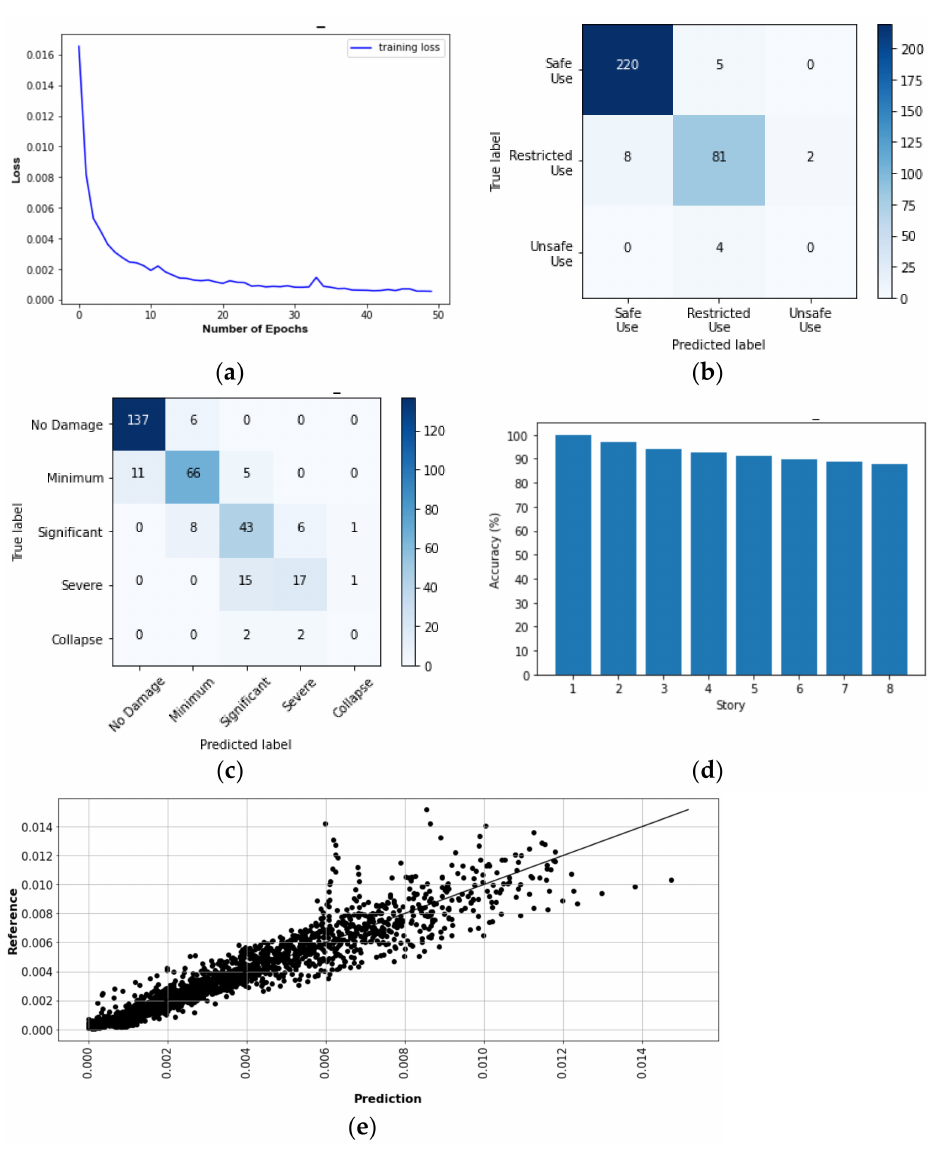
Figure 19. SD results of the TP and VP for Toyohashi Fire Station building: ( a ) convergence curve—loss in the TP; ( b ) confusion matrix—usability of the building by VP; ( c ) confusion matrix—total damage condition by VP; ( d ) confusion matrix—storey damage condition by VP; ( e ) total comparison of SD.